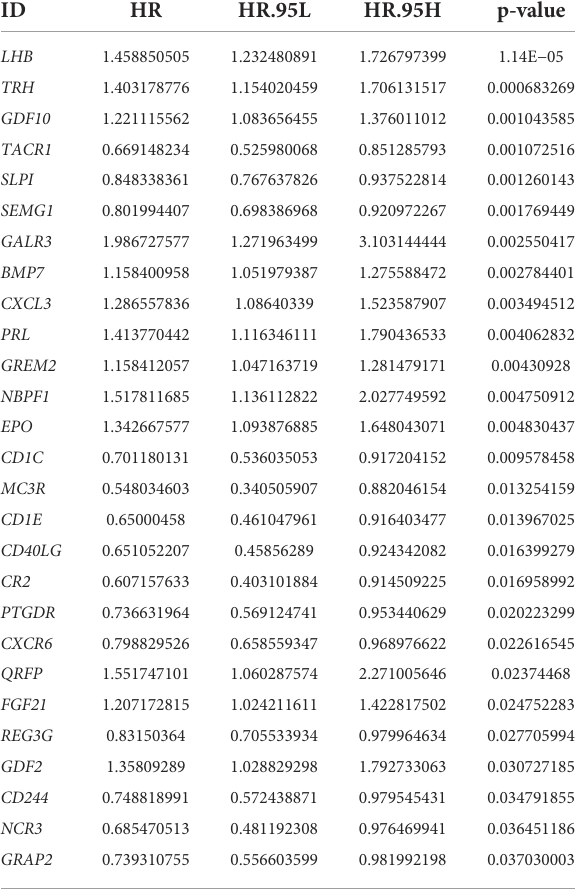
TABLE 3 Immune-related prognostic